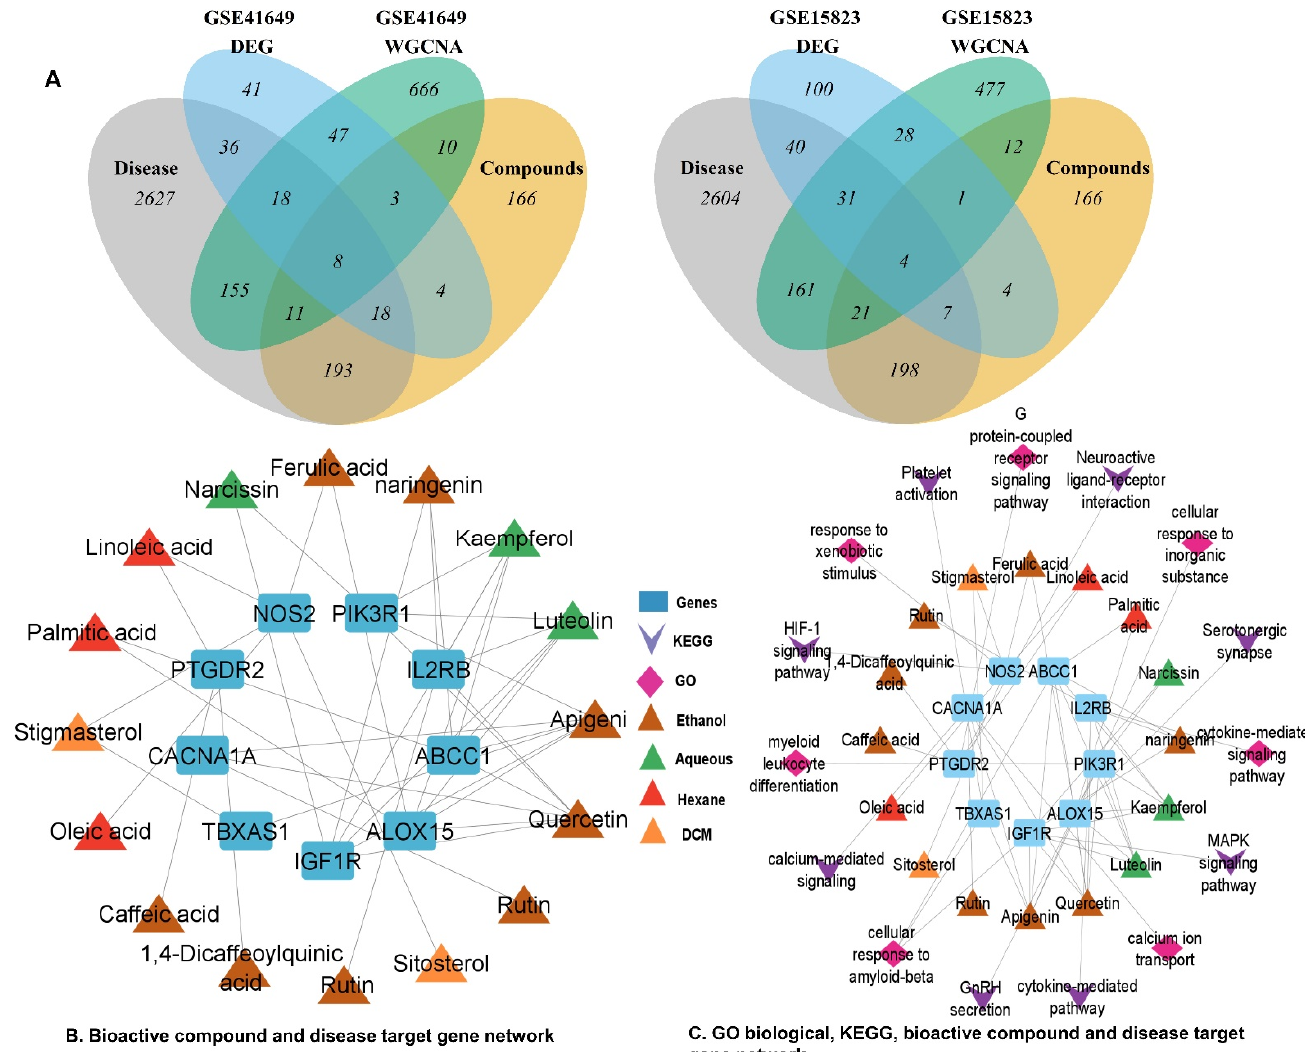
Figure 11. Identification of key genes and network construction. ( A ) Venn diagram of overlapping genes in disease–associated genes, compounds target genes, differentially expressed genes, and WGCNA top 4 modules genes of GSE41649 and GSE15283. ( B ) Compound and disease target genes network ( C ) GO biological process and KEGG pathway network of bioactive compounds and target genes.